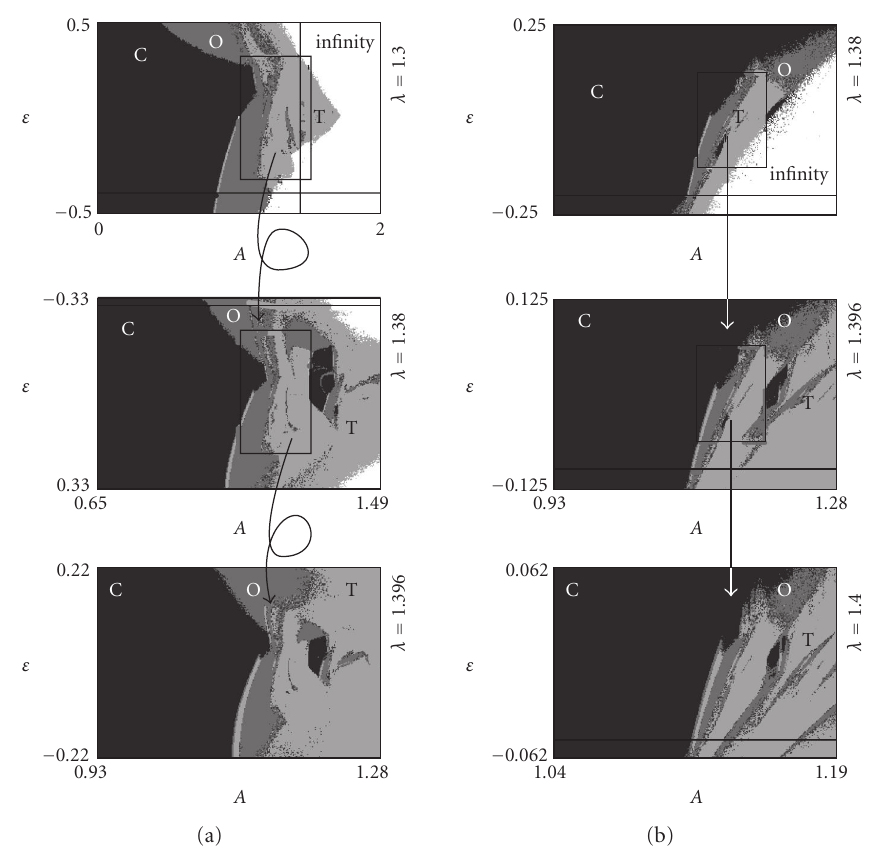
Figure 3.3. Illustrations of scaling in parameter space ( A , ε ) for globally coupled maps with pacemaker for pure dissipative (left side) and pure inertial (right side) couplings. Letter C means coherent phase, letter O means ordered, and letter T—turbulent